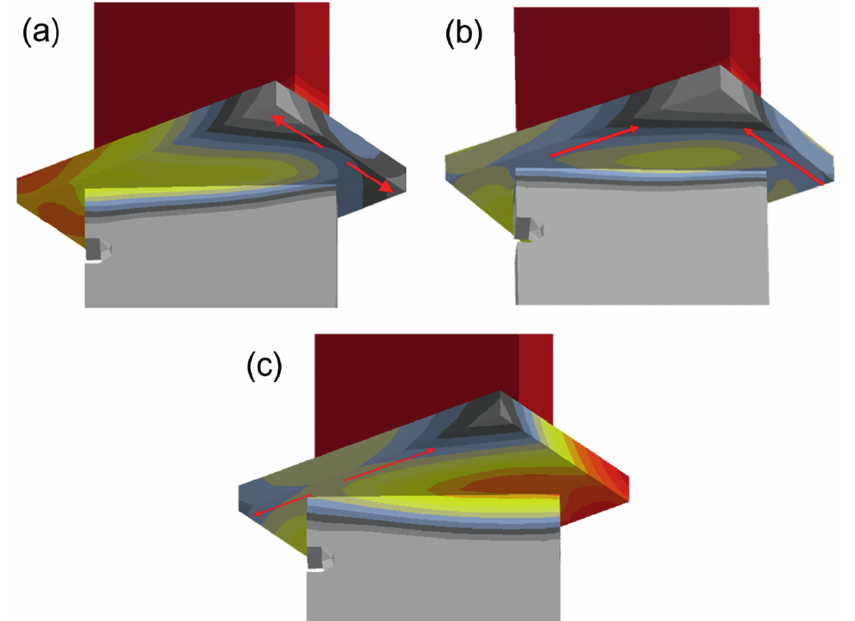
Figure 8: Cooling channels for primary grain growing which are mainly influ- enced by solidification sequence, corre- sponding to the sample of